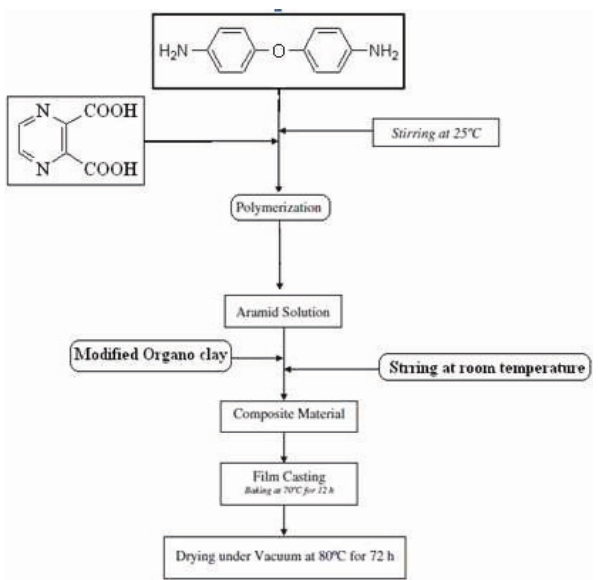
Scheme 2. Flow sheet diagram for the synthesis of PA-